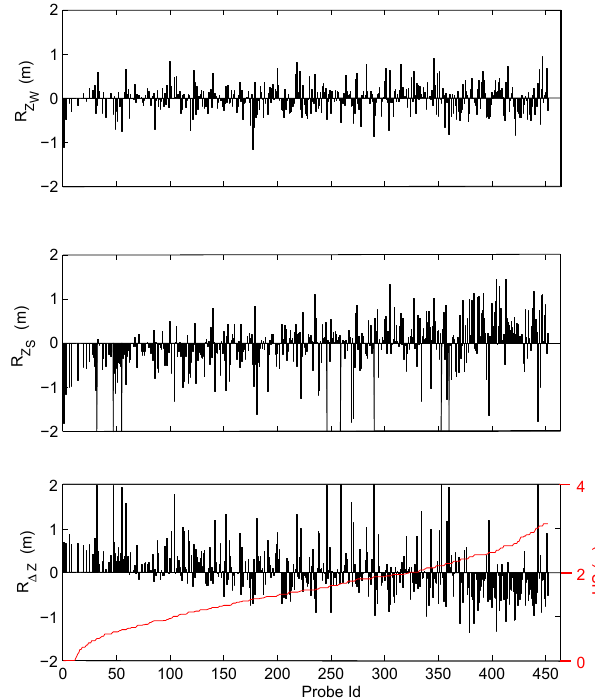
Figure 10. Top: residuals of the comparison between the 2m Pléi- ades winter DEM and the winter DGPS measurements (see Eq. (5), Sect. 4.4.2), after removal of the bias (median of the residuals). Mid- dle: residuals of the comparison between the snow-free 2m Pléi- ades DEM and the estimated summer surface elevation (see Eq. (6), Sect. 4.4.2), after removal of the bias (median of the residuals). Bot- tom: residuals of the comparison between the 2m Pléiades dDEM (black bars) and the snow-probe measurements according to the probe Id ranked in the ascending HS (red line) order (see Eq. (3), Sect. 4.3), and after removal of the bias (median of the residuals).